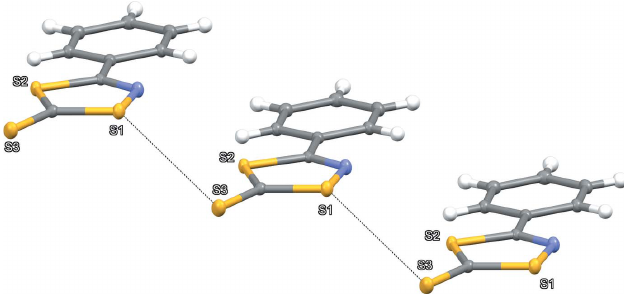
Figure 4 A packing diagram of the title compound showing interchain S (cid:3)(cid:3)(cid:3) S